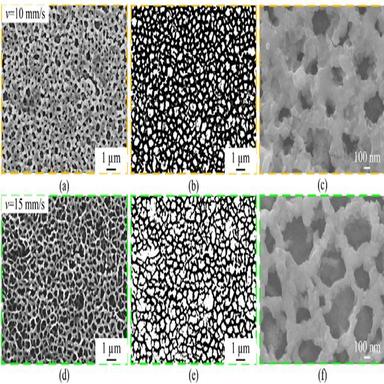
SEM morphologies of two well-defined nanoporous structures with different porosities obtained under the applied laser parameters: (a) P = 1.48 W, v = 10 mm/s, r = 76.6 %, f = 700 kHz, and (d) P = 1.48 W, v = 15 mm/s, r = 76.6 %, f = 700 kHz. (b, e) and (c, f) show the binarized images and the local enlarged images of Fig. 5(a) and (d), respectively.